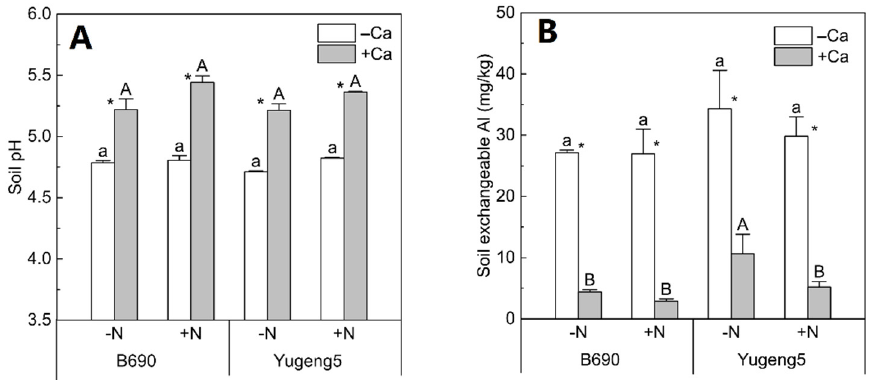
Figure 5. Soil pH and exchangeable Al after harvesting of two rice cultivars ‘B690’ and ‘Yugeng5’. ( A ), Soil pH; ( B ), exchangeable Al. Two rice cultivars were grown in pots in a greenhouse without ( − N) or with ( + N) N fertilizer in the absence ( − Ca) or presence ( + Ca) of lime till maturity. Di ff erent lowercase and capital letters above bars indicate significant di ff erences among di ff erent N treatments under − Ca and + Ca conditions, respectively ( p < 0.05, Duncan’s multiple range test). Asterisks indicate significant di ff erences between − Ca and + Ca treatments ( p < 0.05, independent-sample t test).